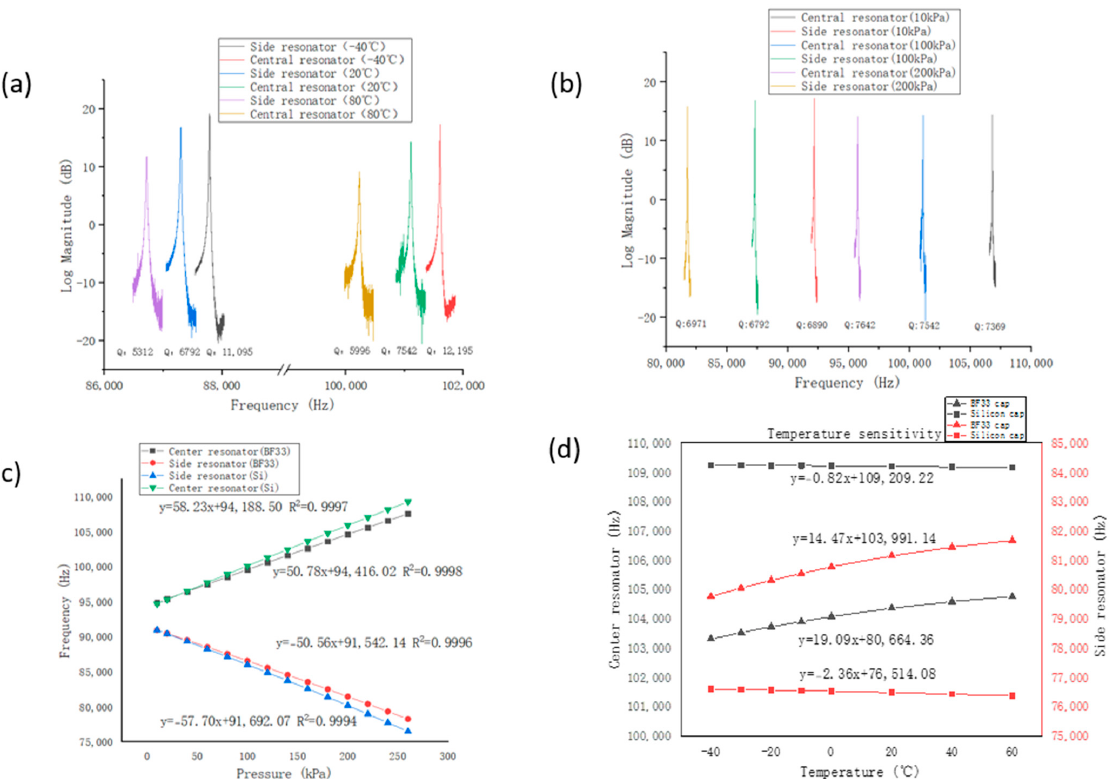
Figure 5. Experimental results. ( a ) Resonance plots of the central and side resonators of the all-silicon resonant pressure microsensor at different temperatures; ( b ) resonance plots of the central and side resonators of the all-silicon resonant pressure microsensor at different pressures; ( c ) resonant frequencies of the central and side resonators with silicon or glass encapsulation as a function of varied pressures (0–260 kPa) under a temperature of 20 °C; ( d ) resonant frequencies of the central and side resonators with silicon or glass encapsulation as a function of temperature variations ( − 40–80 °C) under a pressure of 260 kPa.